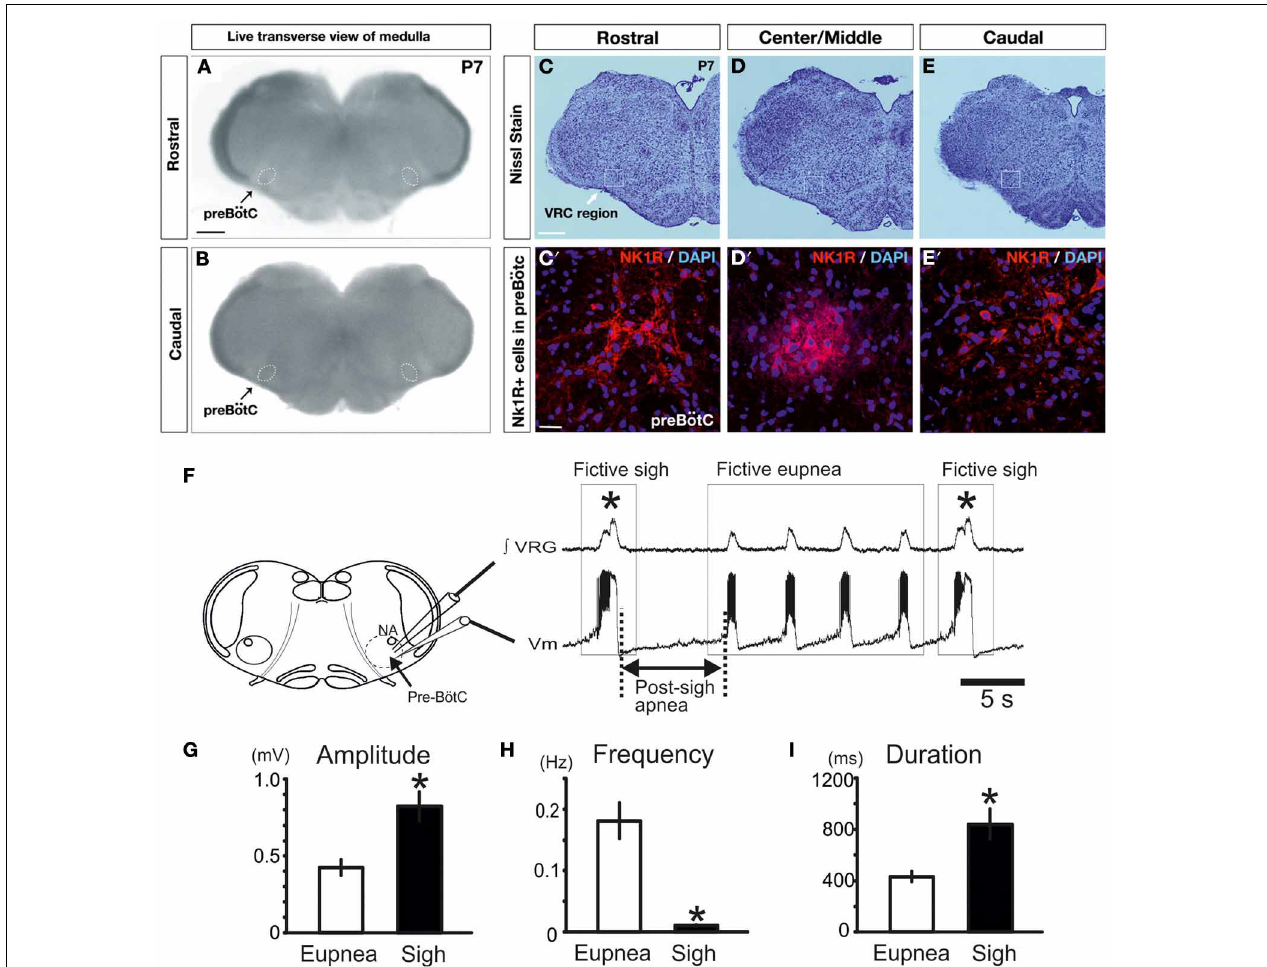
FIGURE 2 | Fictive sigh activity is observed in the in vitro transverse slice preparation. Anatomical characterization of the transverse slice preparation (P7 mouse): (A) rostral and (B) caudal surface of the same live transverse slice preparation. This representative slice preparation was cut into three sections and Nissl staining was used to characterize the rostral (C,C (cid:2) ) and caudal surface (E,E (cid:2) ) , as well as the Center/Middle portion of the slice (D,D (cid:3) ) . NK1 + and DAPI + immunoreactive neurons are depicted in (C (cid:2) –E (cid:2) ) . Note that NK1R staining, which is indicative of the preBötC, is most abundant in the center, but NK1R staining extends also into the rostral and caudal portions of the slice. (F) Schematic of the brainstem slice preparation